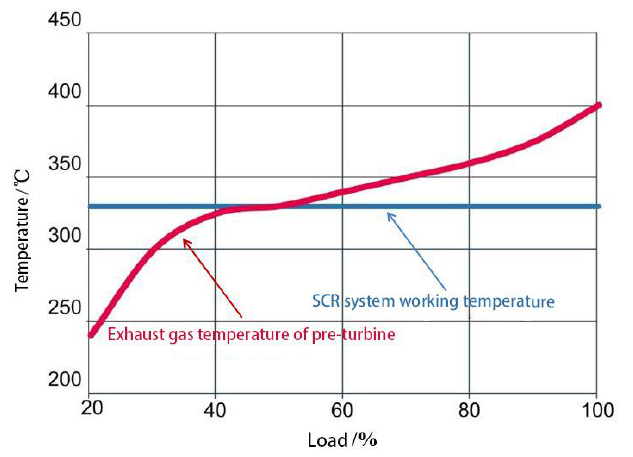
Figure 2. HP-SCR system developed by MAN [18].